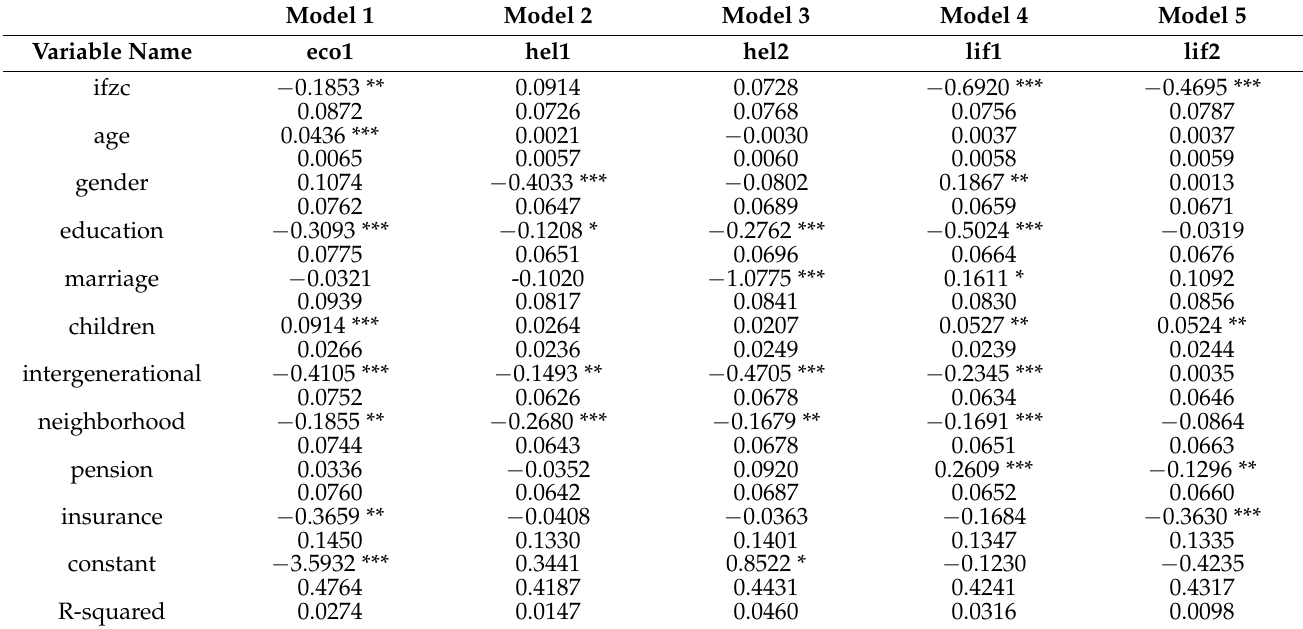
Table 4. Empirical estimation results of rural poverty on rural elderly target